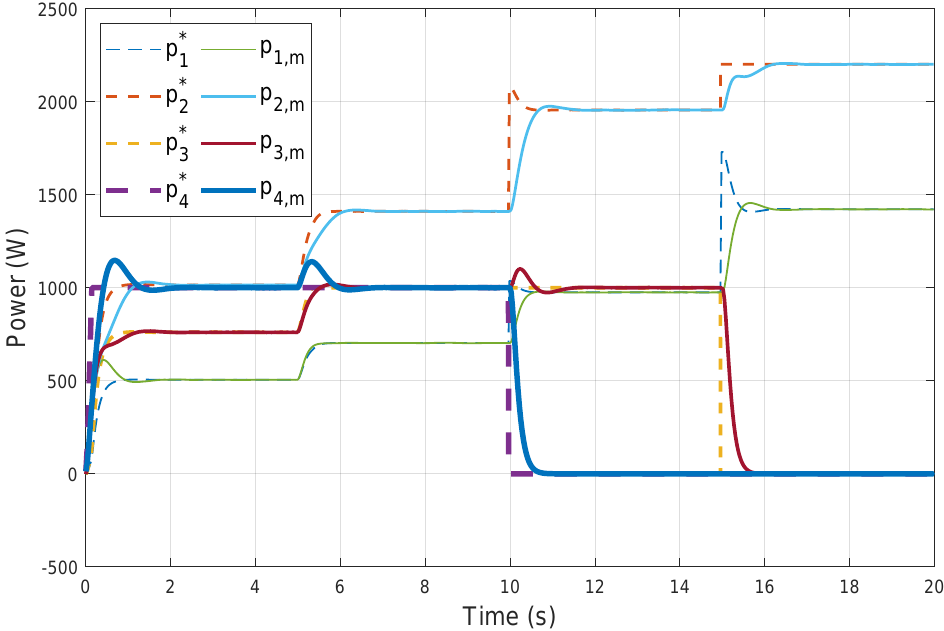
Figure 9. Optimal power allocation and tracking with the real-time EMS. As it was shown by Proposition 1, running the dynamic algorithm (13) and computing in real-time power references based on the Equations (9)–(11), the injected power achieve a proper tracking of the optimal power references ( p ∗ , . . . , p ∗ ). The inner controller shows an adequate tracking performance that leads to 1 4 optimal economic operation in